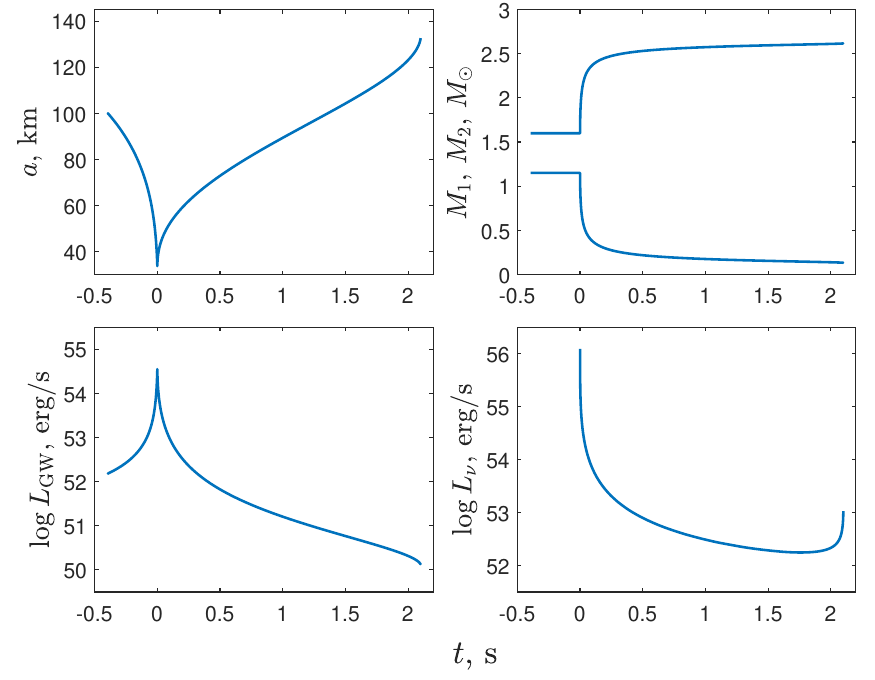
Figure 2. The distance between the components a , their masses M 1 and M 2 , gravitational-wave L GW and “neutrino” L ν luminosities as functions of time t are